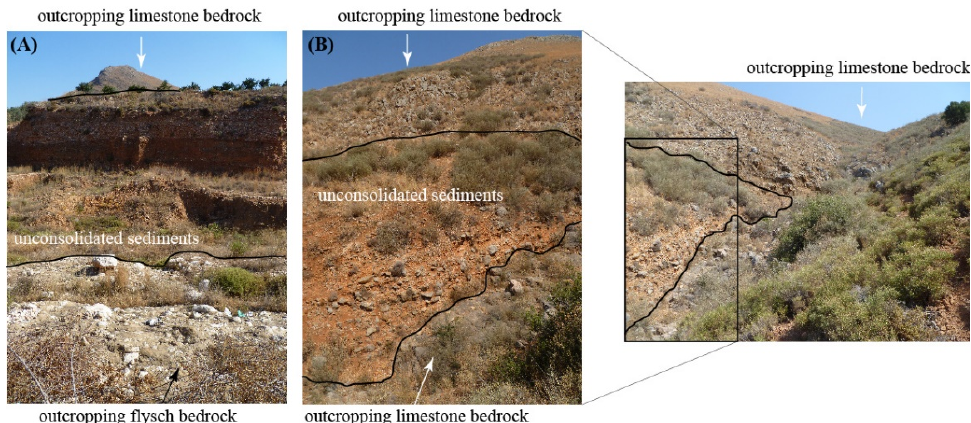
Figure 2. Field photograph of the exposed geologic contact between the Holocene fluviotorrential alluvial ( A ) and colluvial ( B ) unconsolidated deposits deposited over Triassic–Upper Cretaceous bedrock. Karstic limestone dominates the bedrock rock type. The photographs were taken in the easternmost central part of the AB.